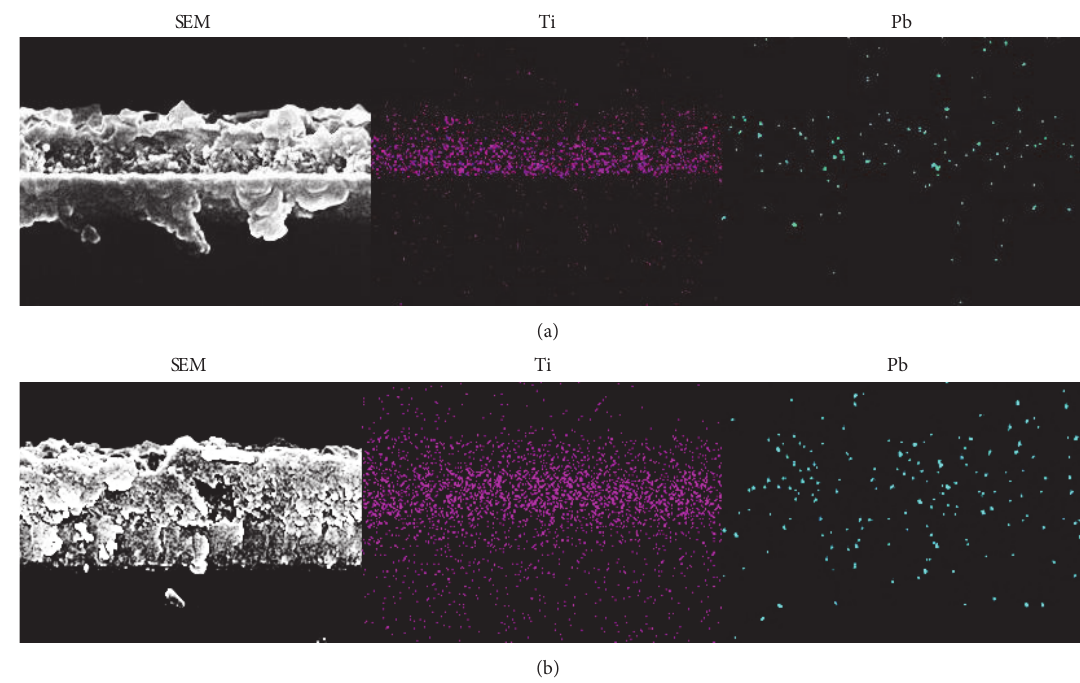
Figure 4: SEM-EDX mapping along the mp-TiO 2 film thickness to show the change in the distribution of Ti and Pb in CH 3 NH 3 PbI 3 loaded on (a) PS-0 and (b) PS-1.0.